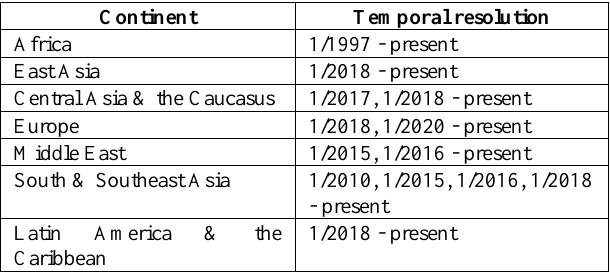
Table 1 . Temporal resolution of ACLED (ACLED.